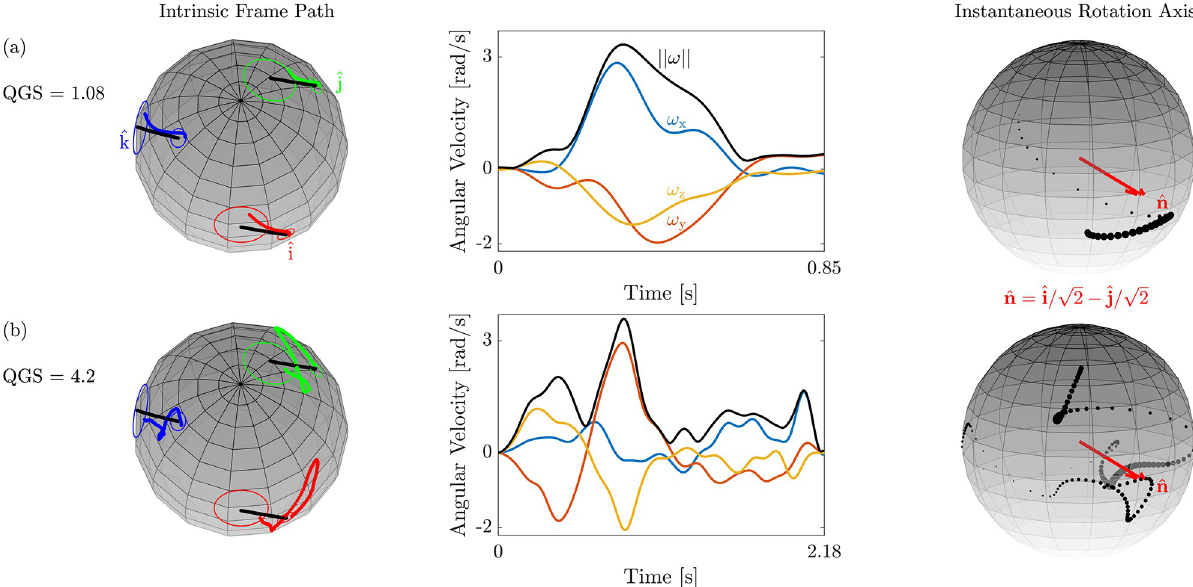
Fig 5. Examples of a geodesic and a non-geodesic. The left column shows the path of the intrinsic reference frame that is attached to the robotic handle ( ^ i —red, ^ j —green, and ^ k —blue). The circles enclose caps that define the accepted range for the hand’s orientation at the initiation of the movement (small caps with angular aperture of 5˚) and at its termination (large caps with angular aperture of 15˚). The black curves describe the geodesic between the initial cursor orientation and the target orientation. The middle column shows the angular velocity profile (x—blue, y—orange, and z—yellow) used to follow the orientation path, as well as its norm (black), and the right column describes the path of the instantaneous rotation axis (black dots). To emphasize fast segments, the size of the black dots is scaled in proportion to the angular speed. The ideal rotation axis is shown in red. (a) The trajectory of the intrinsic frame of a geodesic follows a short path on the sphere and is characterized by a smooth angular velocity profile and a concentrated instantaneous axis path. (b) The trajectory of the intrinsic frame of a non-geodesic follows a longer path on the sphere compared to that of the geodesic and is characterized by a fragmented angular velocity profile and a dispersed instantaneous axis path. In both examples, the initial cursor orientations and the target orientations were